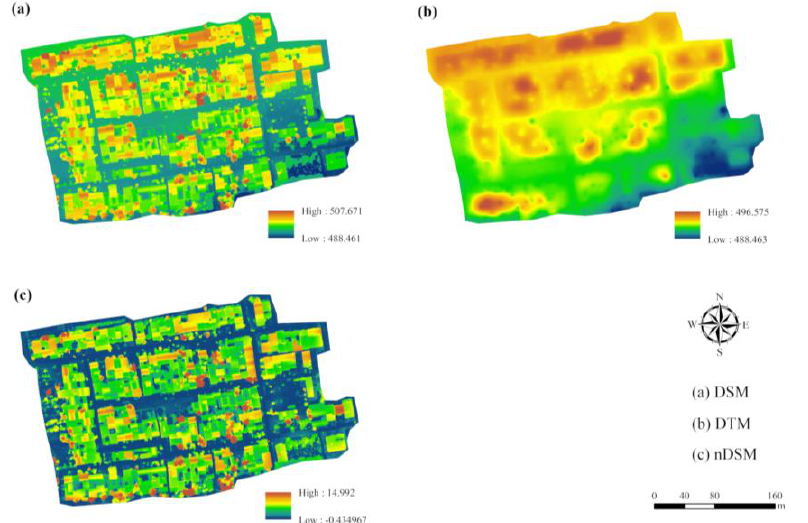
Figure 11. UAV-based estimation of the number of floors in rural buildings. ( a ) The DSM based on the photogrammetry workflow with the overlapping UAV images, ( b ) the DTM based on the point cloud filtering algorithm with the DSM images, and ( c ) the DTM subtracted from the DSM to create the nDSM.